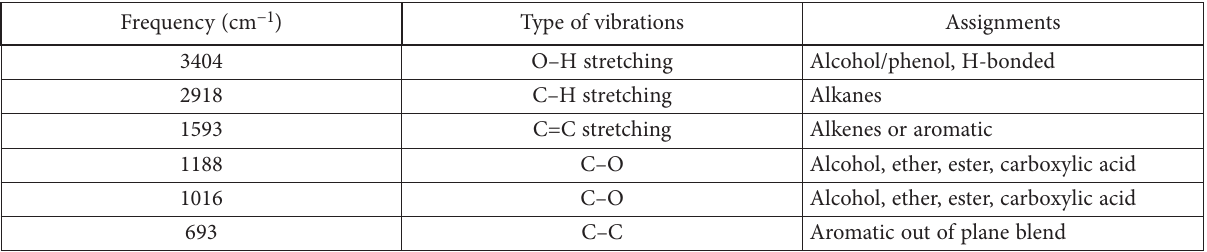
Figure 7. Kinetic study plot [ln b vs. (1/ T )×10 3 ] of keyboard plastic waste using Flynn-Wall-Ozawa method at different conversion Table 2. Important assignments from Fourier Transform Infrared Spectroscopy analysis of keyboard plastic